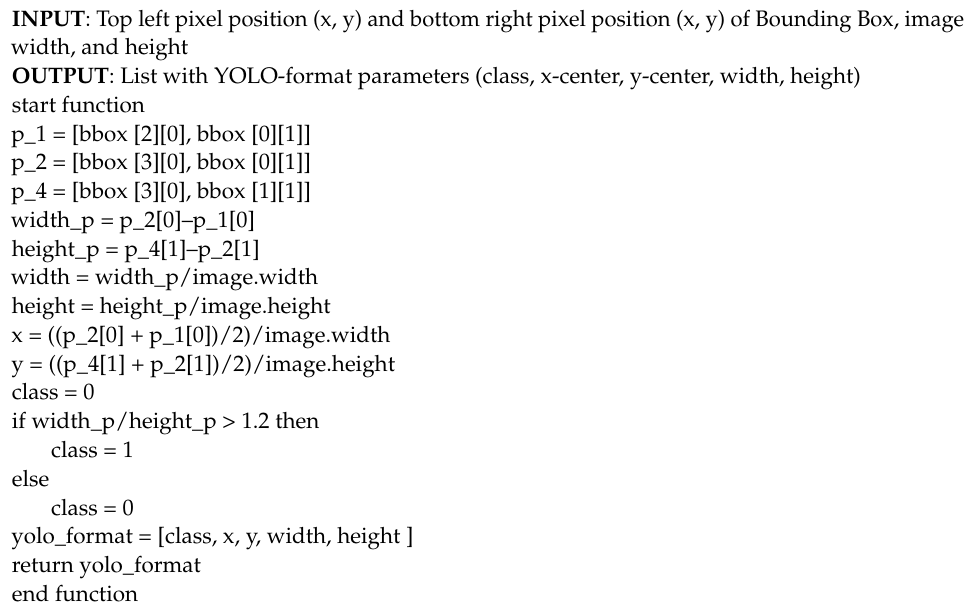
Algorithm 1 Tailoring data labeling for the target model